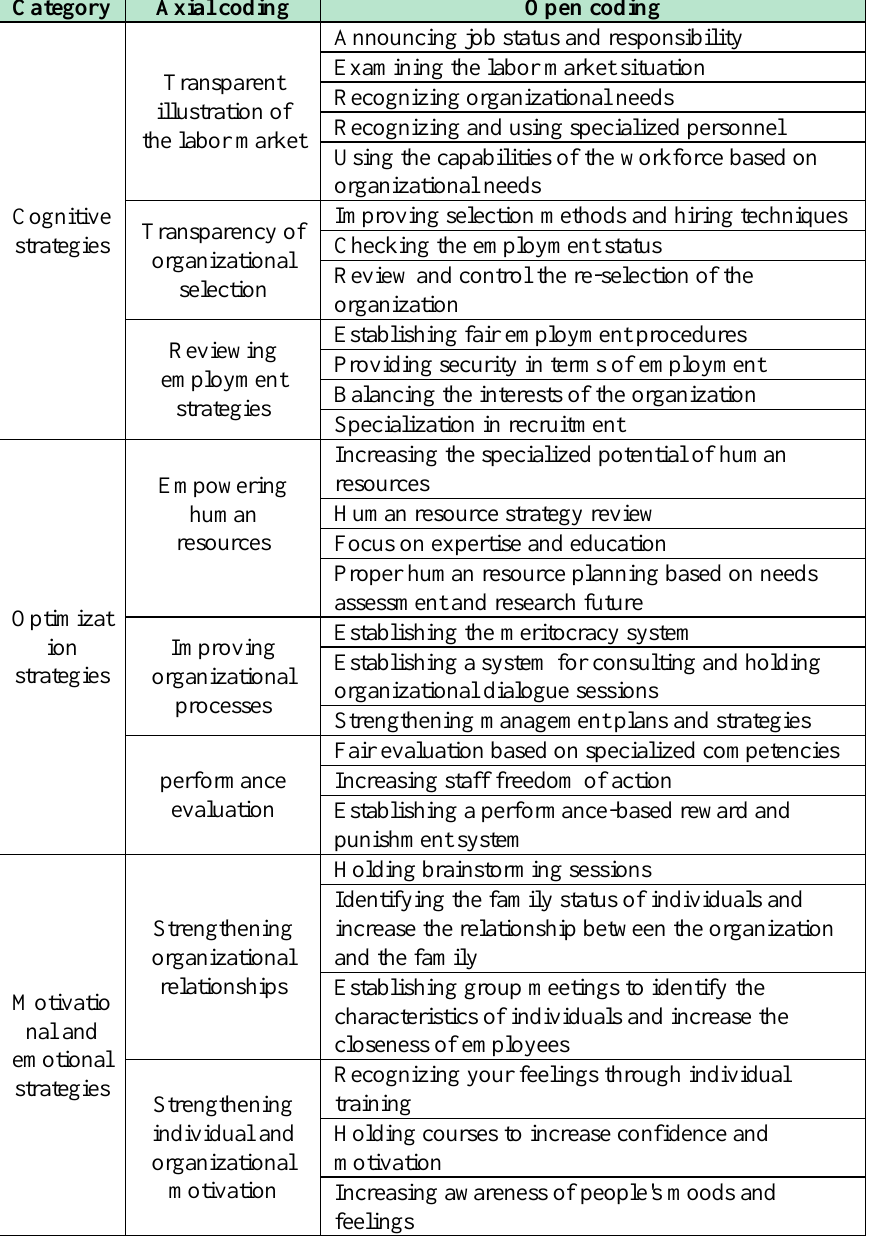
Table 2- Open coding of qualitative data (strategic conditions) Category Axial coding Open